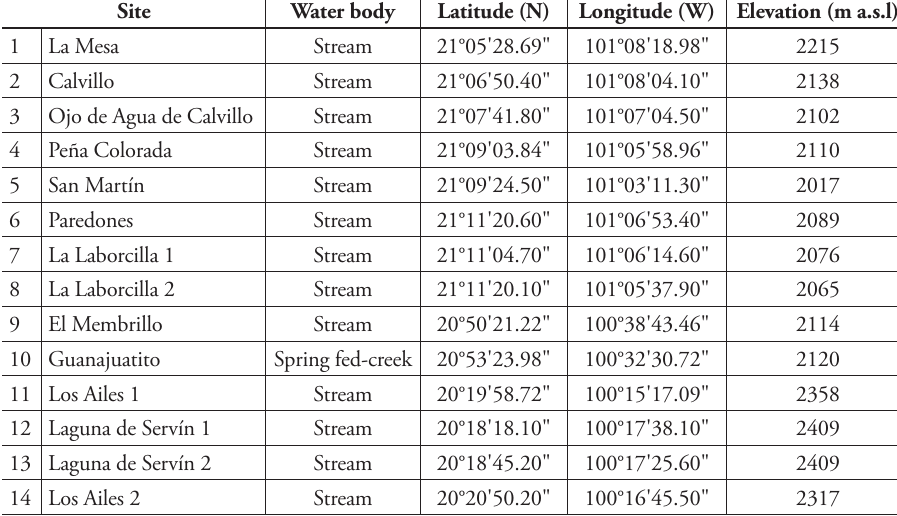
Table 1. Sampling sites in the Lerma-Chapala Basin, including site number and name, type of water body, geographical coordinates and elevation.